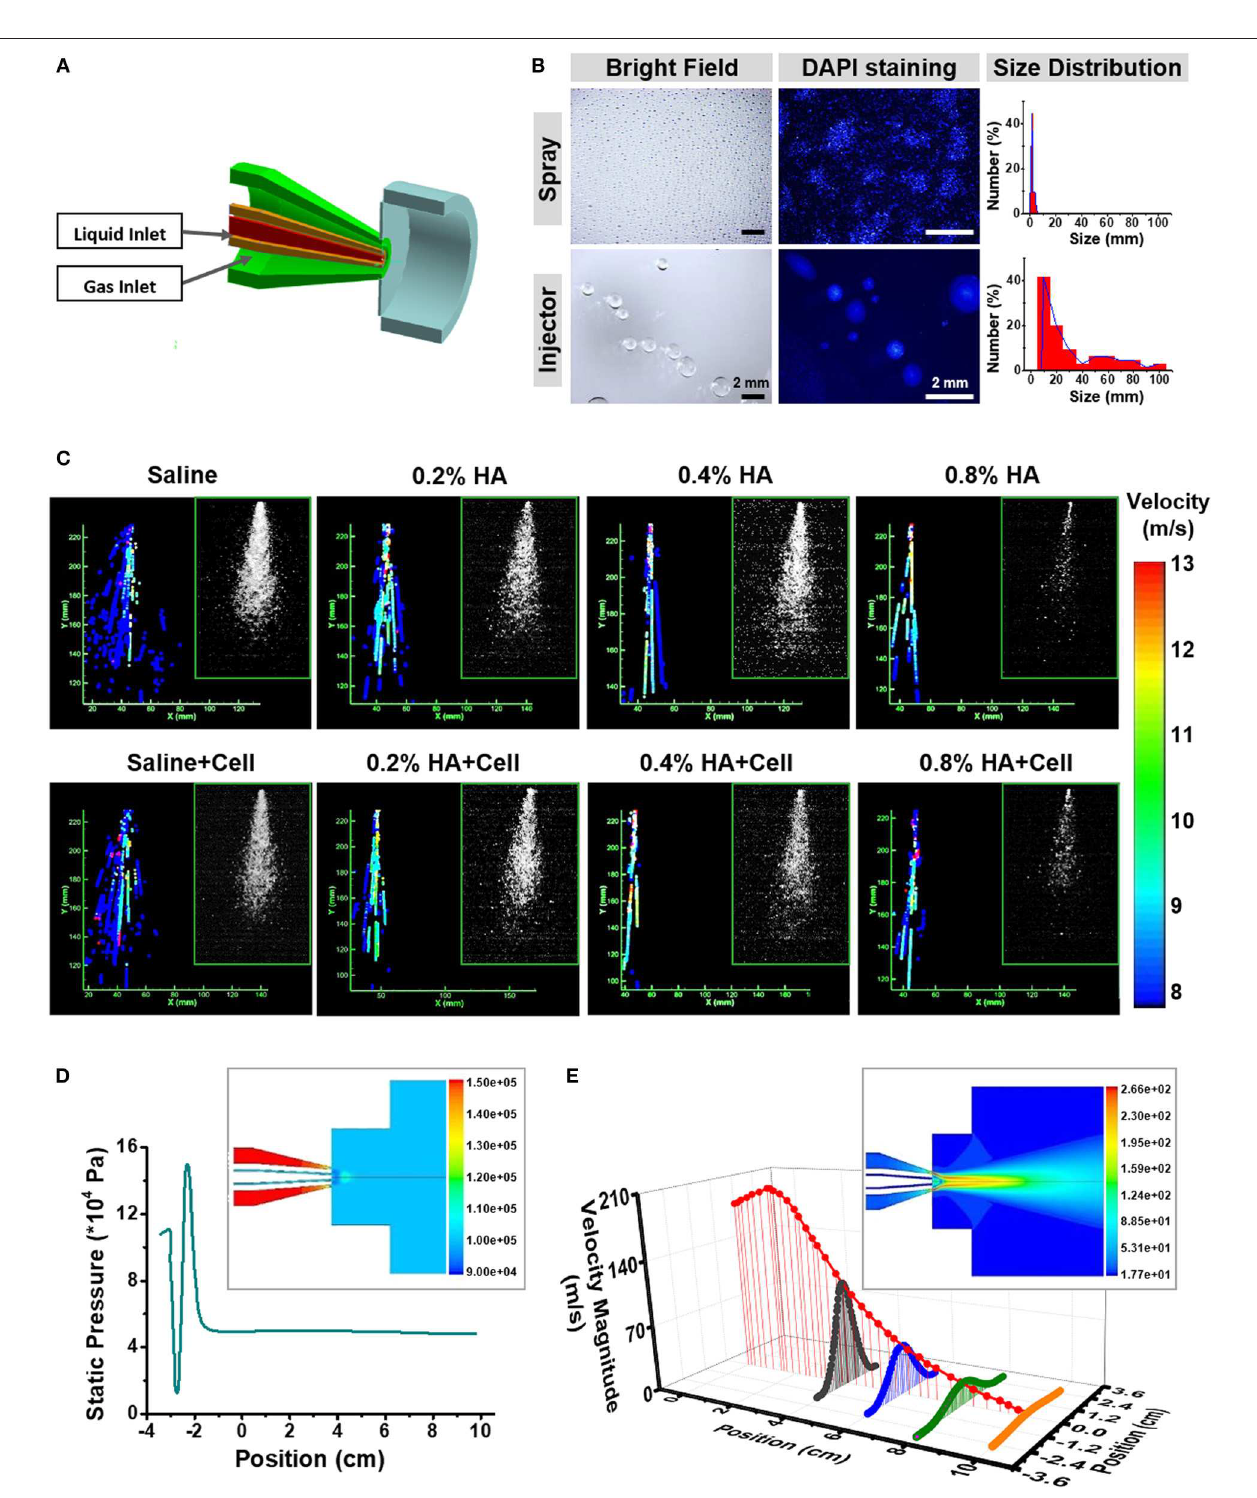
FIGURE 2 | Fluid dynamics analysis of the AMAD. (A) The structural and working principle diagram of the nozzle, including the liquid and gas outlet. (B) Bright field and fluorescent images showing the droplets sprayed by the AMAD and injector and their size distribution. (C) The velocity distribution of different liquid at a series of viscosity, which analyzed from the laser-triggered high-speed photography (inside the frame). (D) The gas static pressure distribution of nozzle and outlet jet (inside the frame), and the distribution of gas static pressure on the central axis. (E) The gas velocity distribution of nozzle and outlet jet (inside the frame), and the axial and radial distribution of gas velocity after